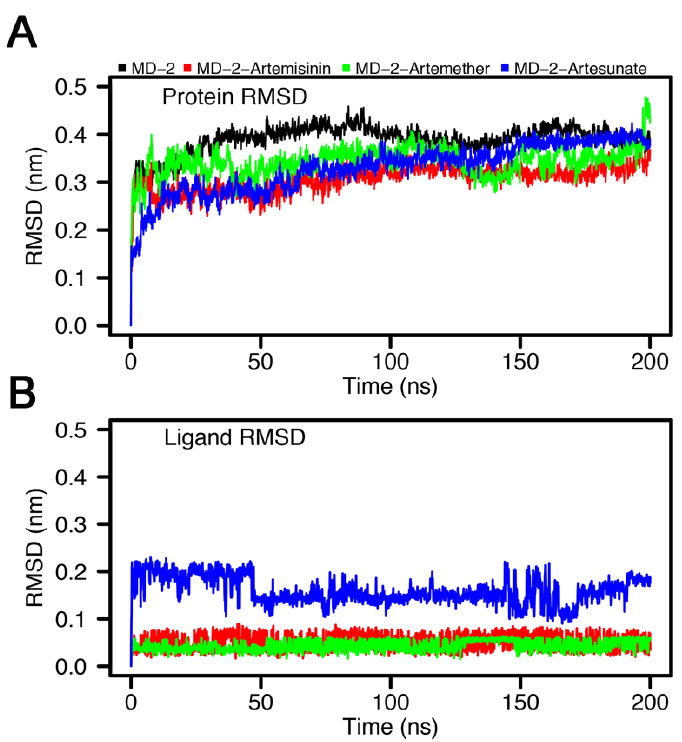
Figure 4. Root mean square deviations of ( A ) the MD-2 backbone atoms and ( B ) the ligand over 200 ns of